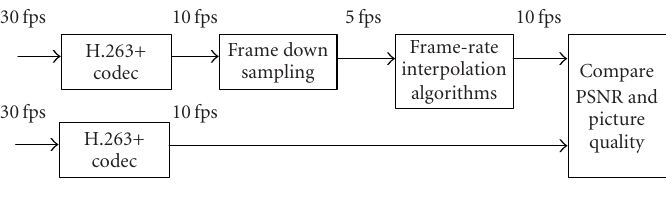
Figure 3: Simulation